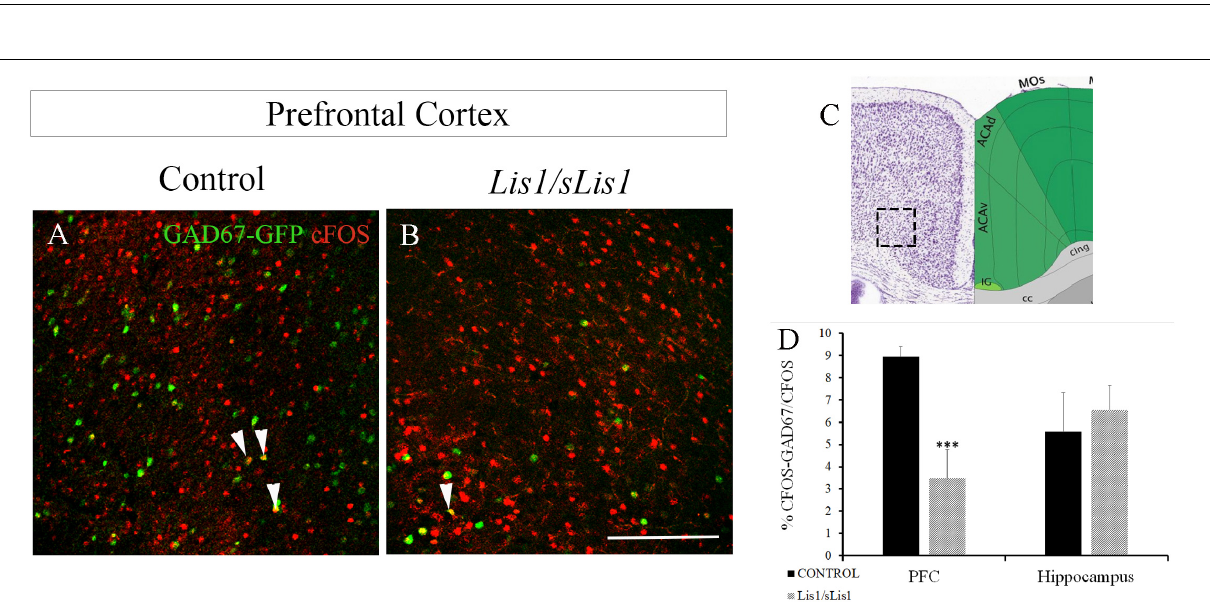
Frontiers in Cell and Developmental Biology | www.frontiersin.org